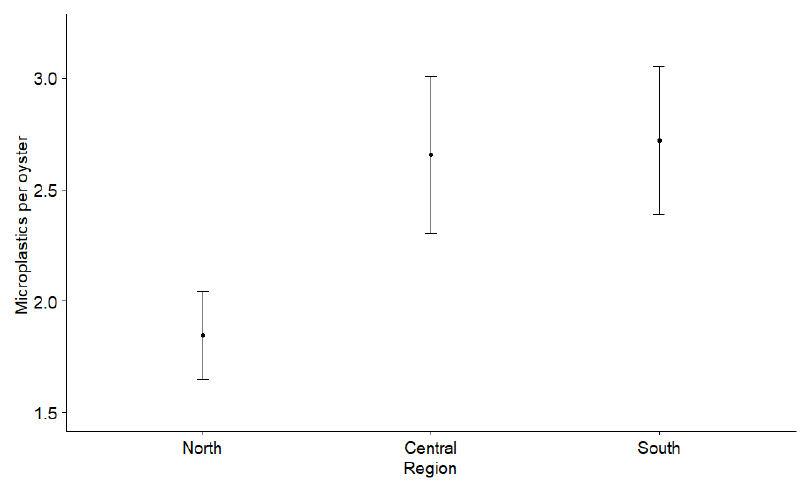
Figure 3. Microplastic abundance by region in Indian River Lagoon oysters. Values reported are the mean (point) and the 95% confidence interval of the mean (error bar). (GLM, p = 0.01, North = 710, Central = 345, South = 347).